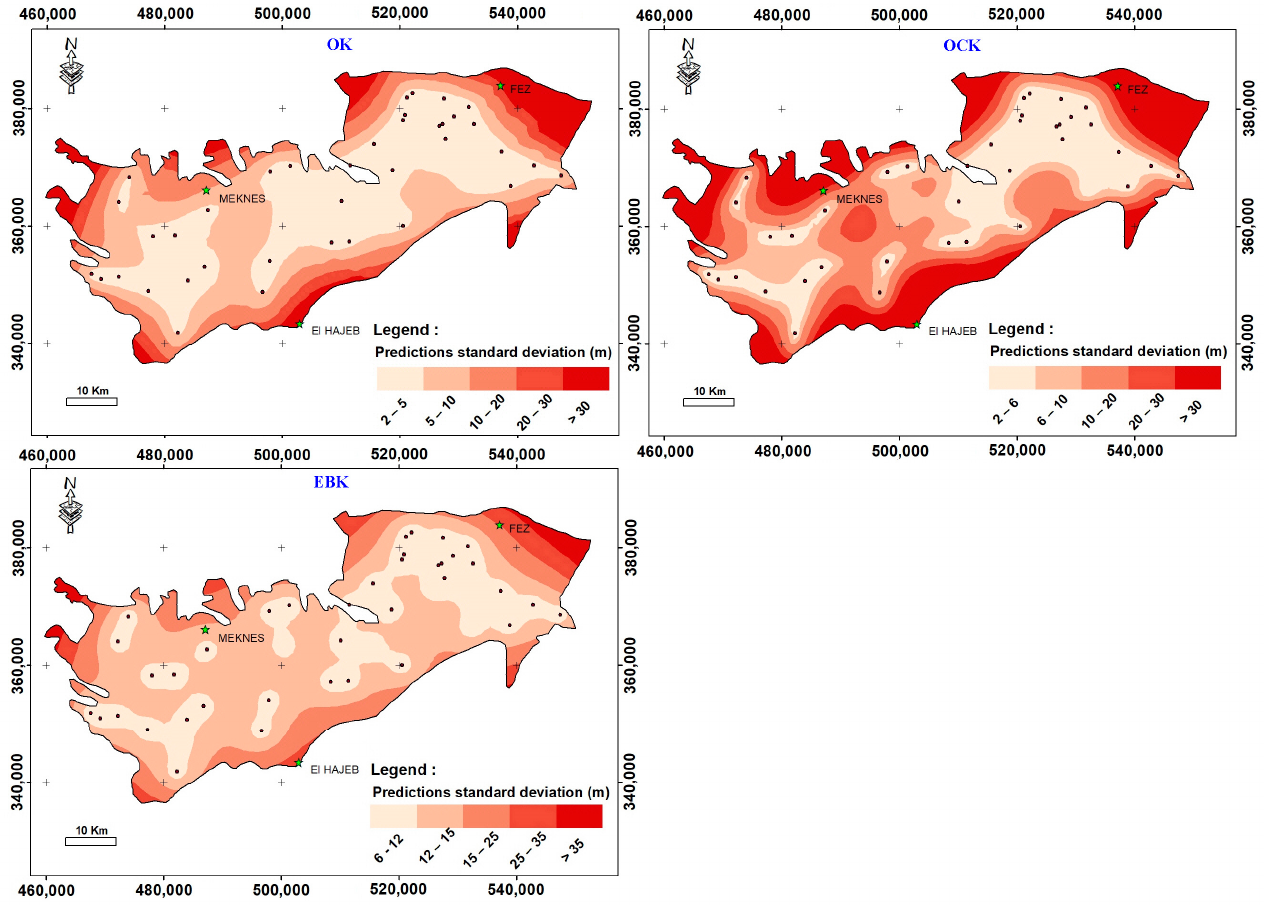
Figure 9. Groundwater level prediction errors map for ordinary kriging (OK), ordinary cokriging (OCK), and empirical Bayesian kriging (EBK) .